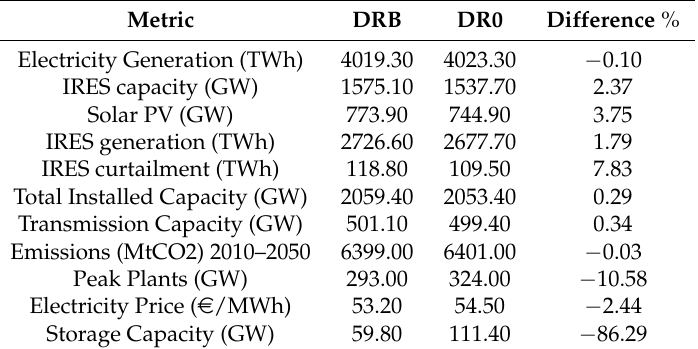
Figure 6. Europe’s Generation Difference between DR0 and DRB by period. Positive y-axis indicates larger energy generation in DRB than in DR0 and vice versa. Table 2. Main differences between cases DR0 and DRB in 2050.